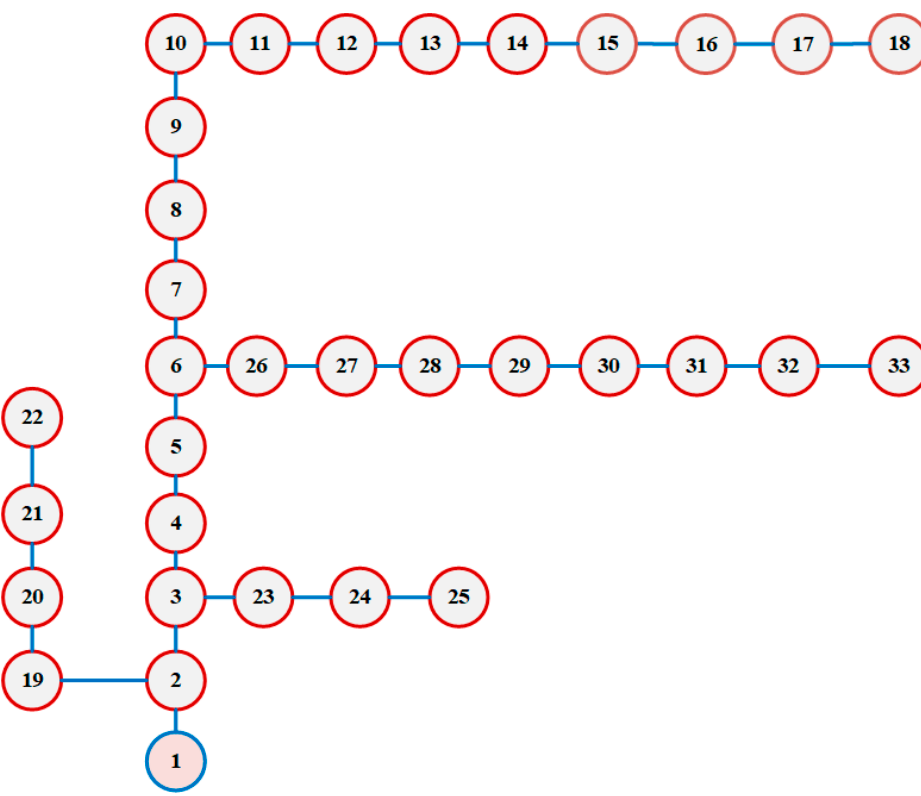
Figure 3. The IEEE 33-distribution system.